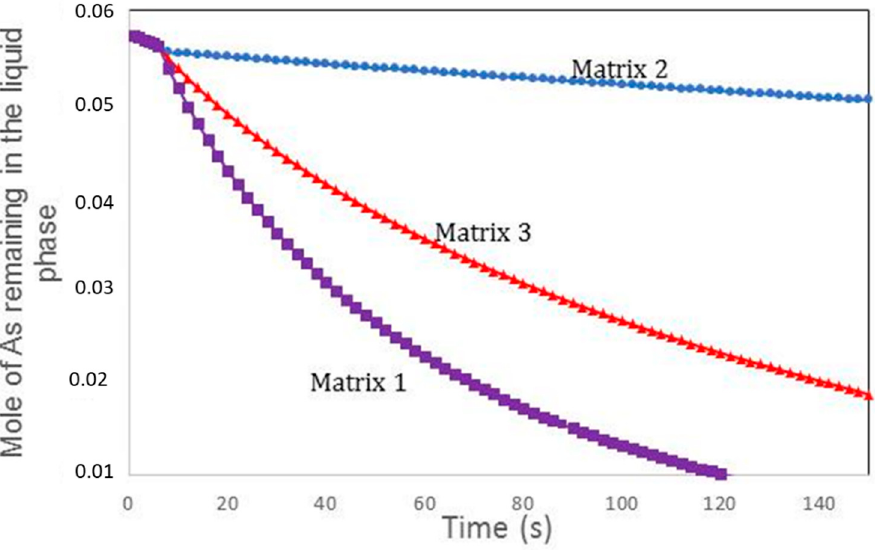
Figure 9. Influence of composition of confinement matrix on the volatility of